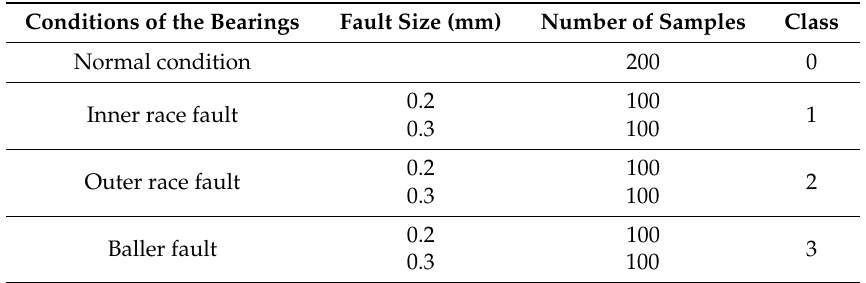
Table 5. Datasets obtained at motor speeds of 2000 rpm, 2500 rpm and 3000 rpm on the CUT-2 platform.